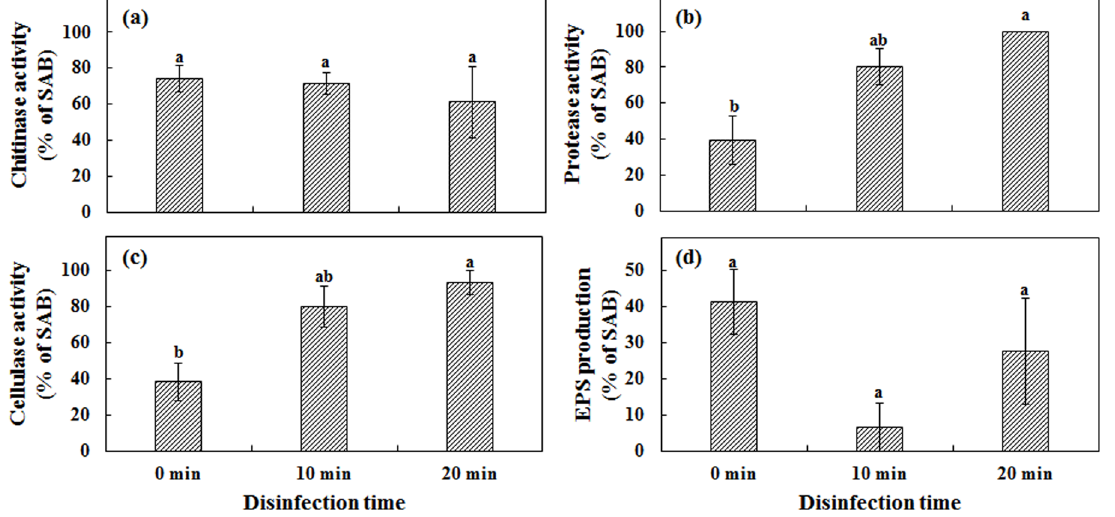
Fig 3. Spore associated characters of SAB. (a) – chitinase activity; (b) – protease activity; (c) cellulase activity; (d) EPS production. Means with same letter do not differ significantly according to DMRT test at P < 0.05 (arcsine transformed